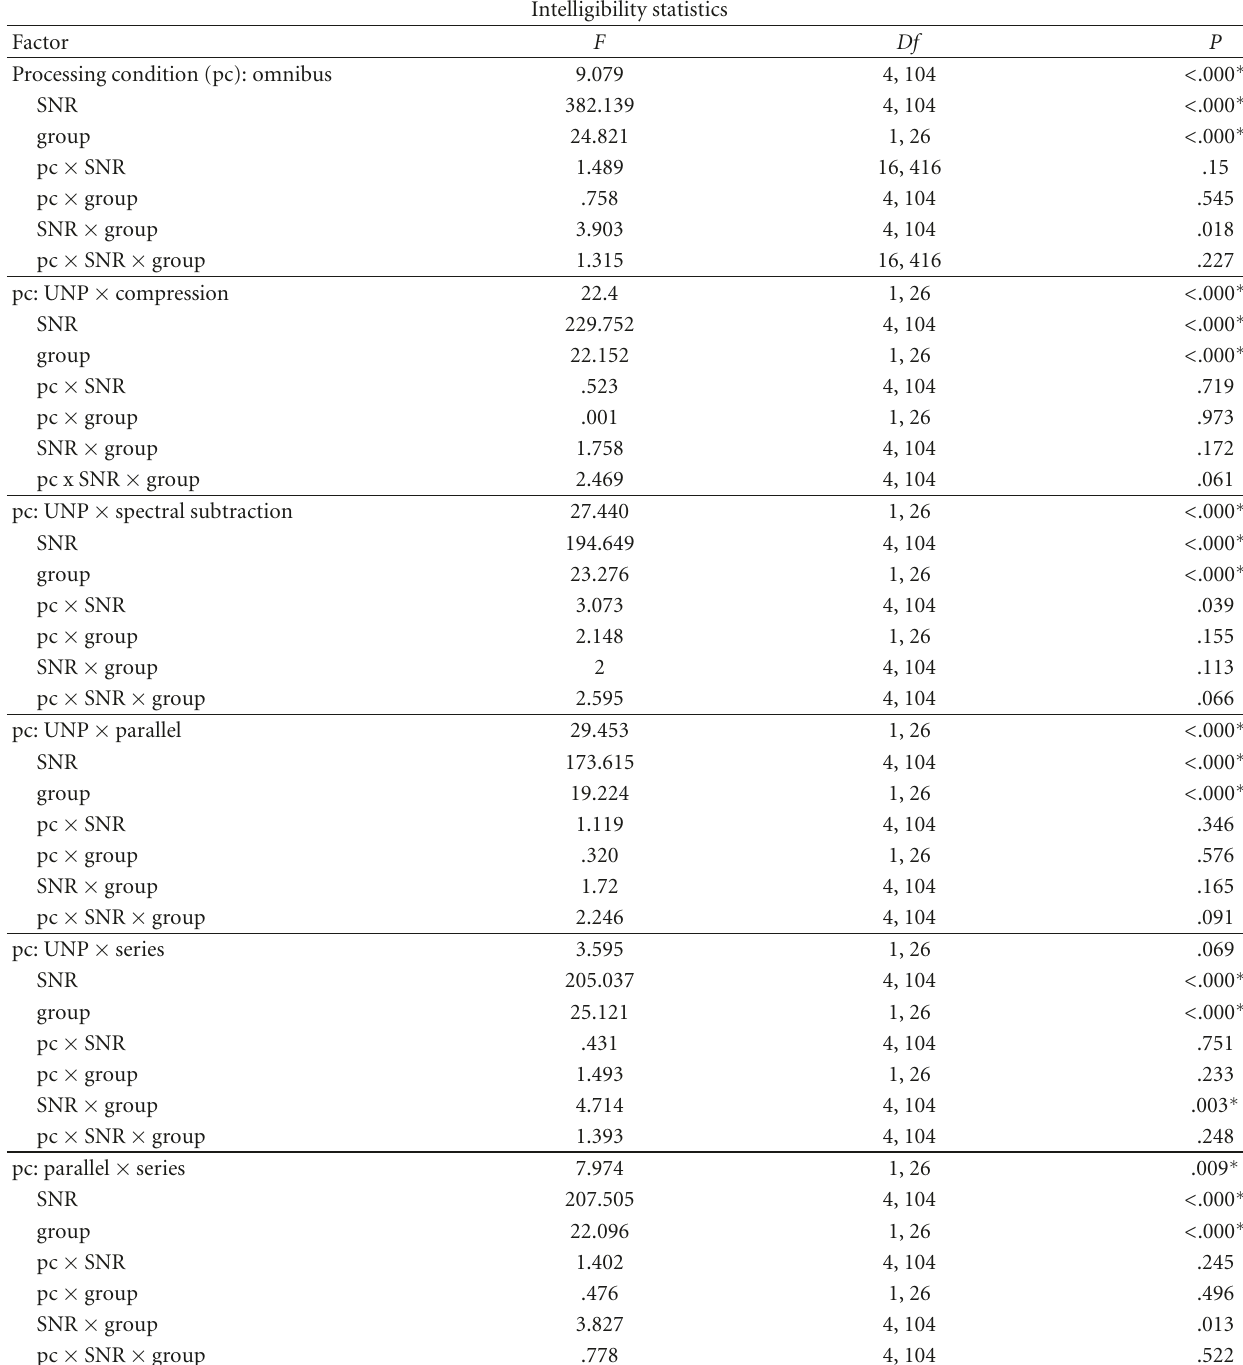
Table 2: Results of repeated measures ANOVA for intelligibility scores. Statistical significance (marked with an ∗ ) is P < .01 due to Bonferroni